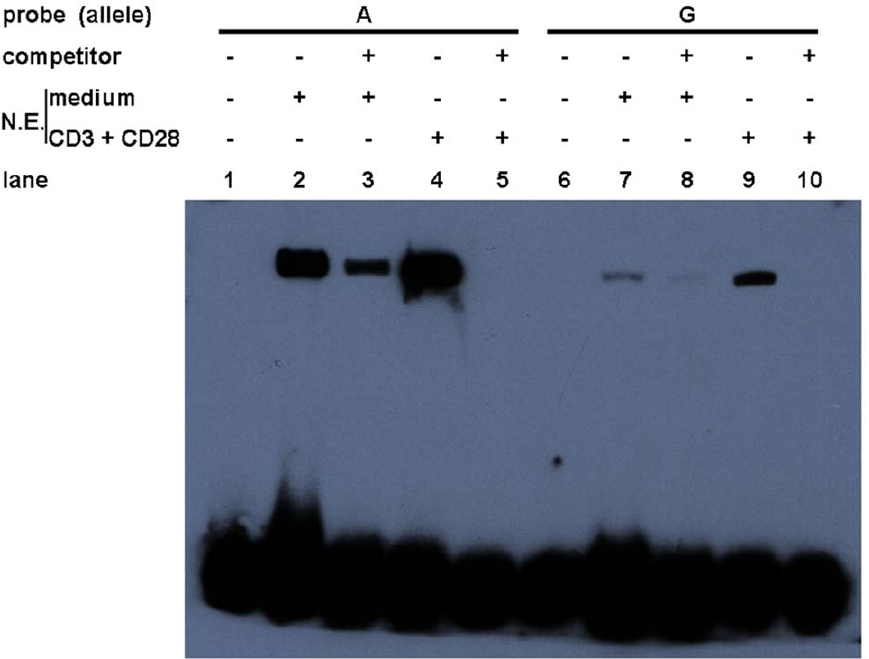
Figure 3. Allelic difference of rs57095329 in binding affinity to nuclear proteins. Shown is a gel-shift assay of the allelic probes (A or G) with nuclear extracts (N.E.) prepared from either rested (medium) or anti-CD3 + anti-CD28-activated Jurkat cells. Also shown are the results of a competition assay performed with the addition of 100-fold unlabeled competitor oligonucleotides. The experiment was repeated three times.